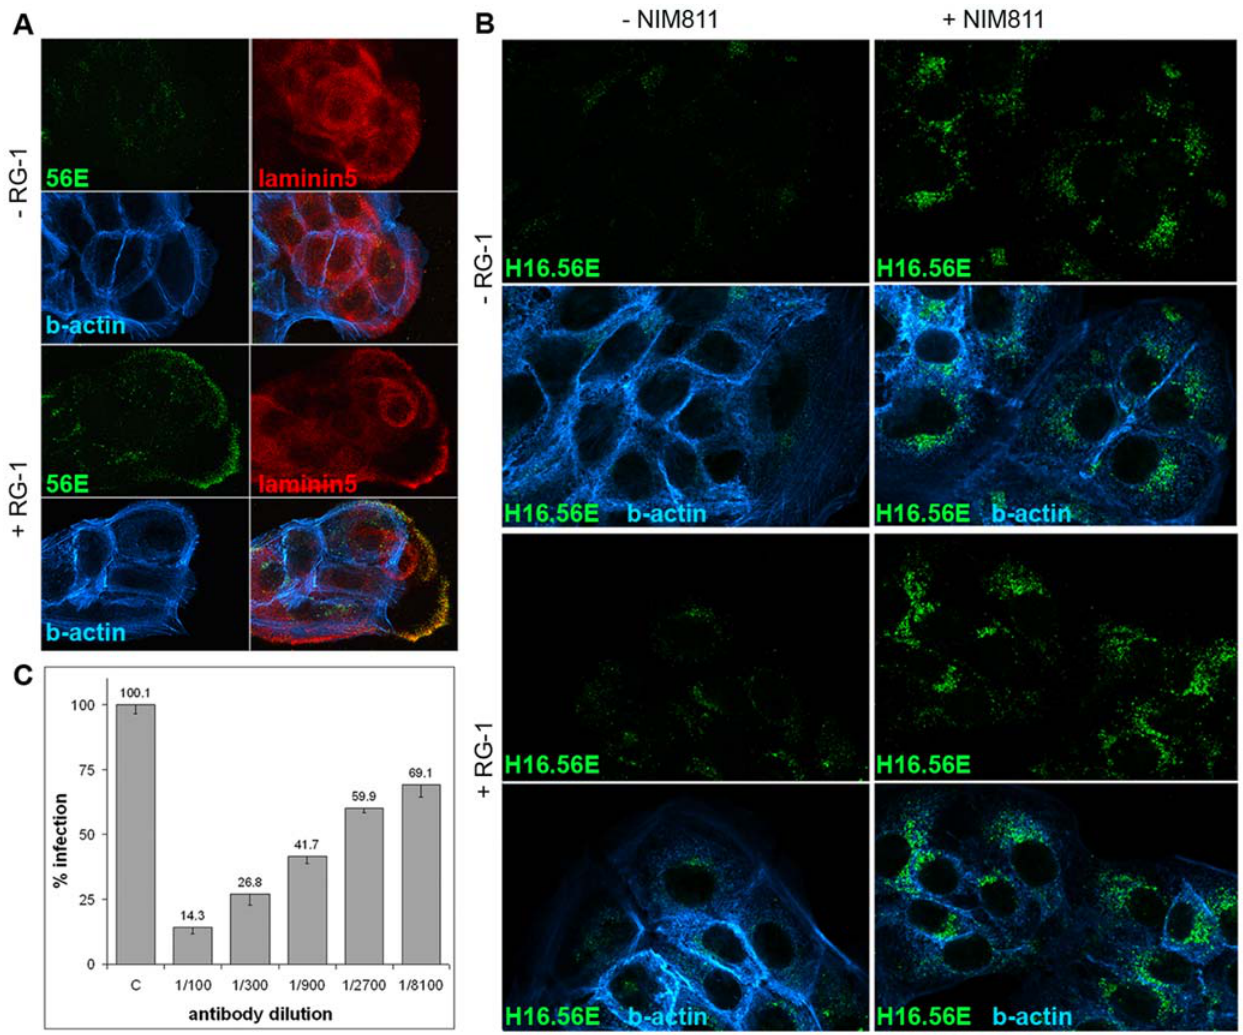
Figure 5. Effect of RG-1 on particle internalization. (A) HPV16 pseudovirus was added to HaCaT grown on coverslips and incubated for 18 h at 37 u C in the presence or absence of RG-1 (1:10 dilution of cell culture supernatant). Samples were stained for viral particles and ECM using H16.56E and rabbit polyclonal antiserum specific for laminin 5, respectively. Note the accumulation of viral particles on ECM in presence of RG-1. As fixation prior to addition of secondary antibody destroys reactivity with RG-1 [24, and our own observations], the signal picked up by mouse-specific secondary antibody is solely attributable to H16.56E. (B) HaCaT cells were grown and infected as above with the addition of NIM811 during the incubation where indicated. Samples were stained with H16.56E. Note that the presence of RG-1 did not affect the stabilized capsid phenotype and viral internalization irrespective of NIM811 treatment. Images were taken with a Zeiss LSM at 63 6 magnification focusing on ECM (A) and cells (B), respectively. Actin staining with labeled phalloidin is shown in blue. (C) Neutralization of HPV16 by RG-1 at indicated dilutions was measured at 72 hpi of 293TT cells (n=5).